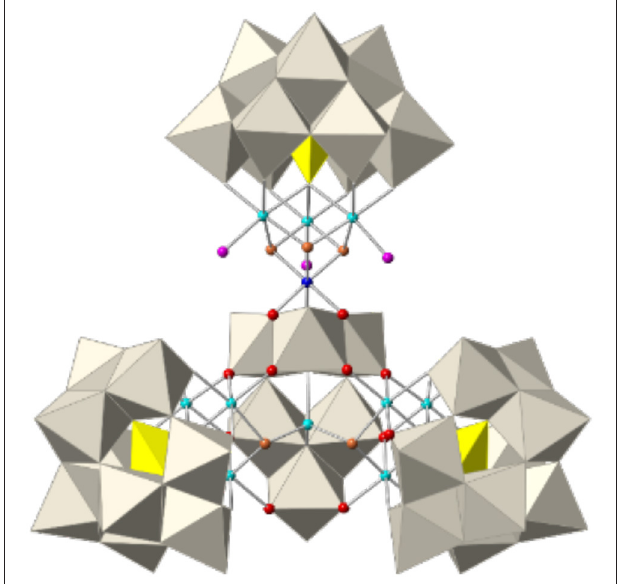
FIGURE 3 | Polyhedral and ball-and-stick representation of the [Co 11 (OH) 5 (H 2 O) 5 (W 6 O 24 )(PW 9 O 34 ) 3 ] 22 − polyoxoanion ( 3 ). Grey octahedra, {WO 6 }, yellow tetrahedra; {PO 4 }, cyan spheres; Co II , blue sphere; Co III , red spheres; O, orange spheres; OH, pink spheres, H 2 O.